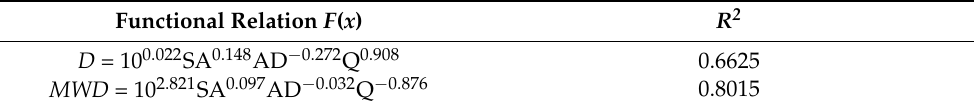
Table 6. Eroded sediment separation characteristic parameters as function of litter characteristics.